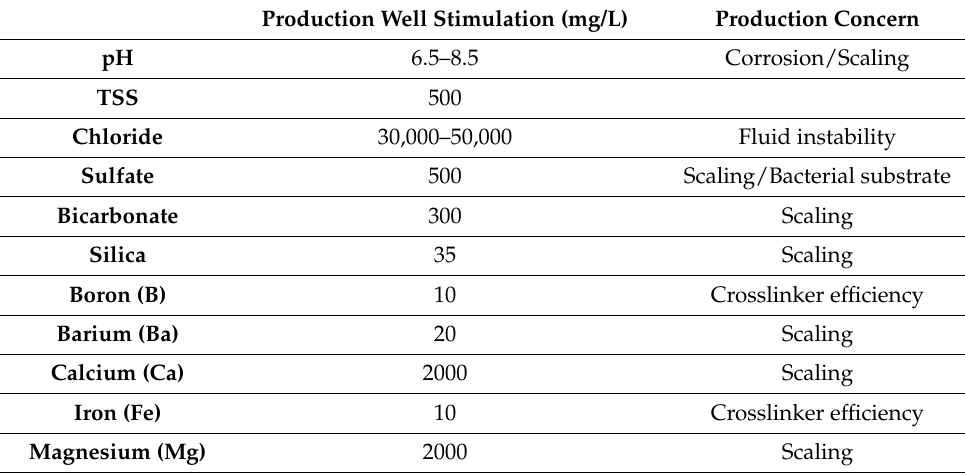
Table 1. Maximum contaminant limits for production well stimulation fluid